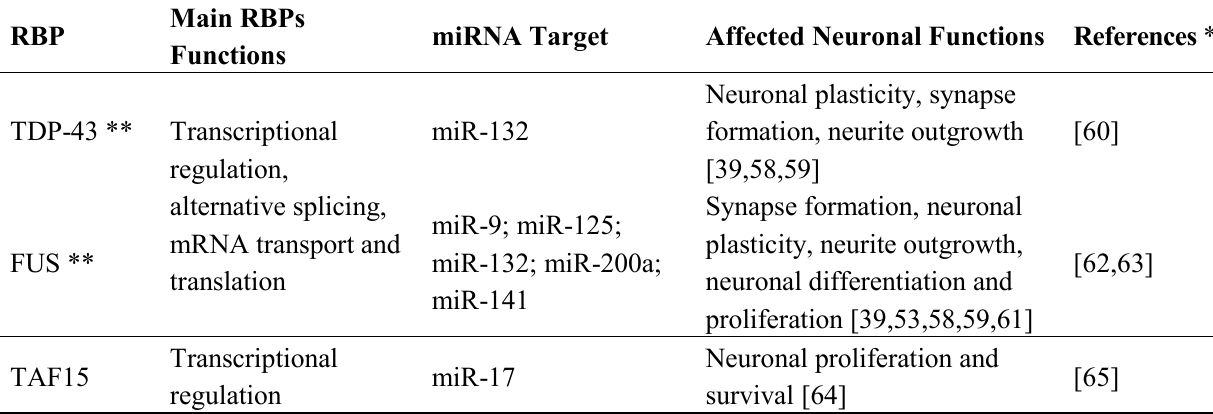
Table 1. RBPs affecting miRNA